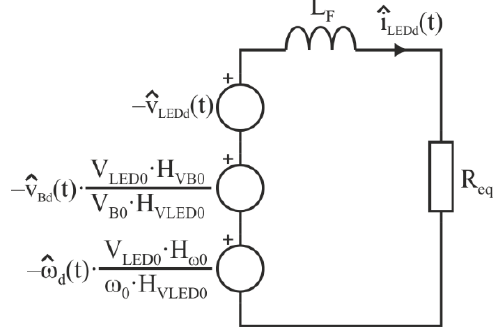
Figure 9. Small signal dynamic equivalent circuit.